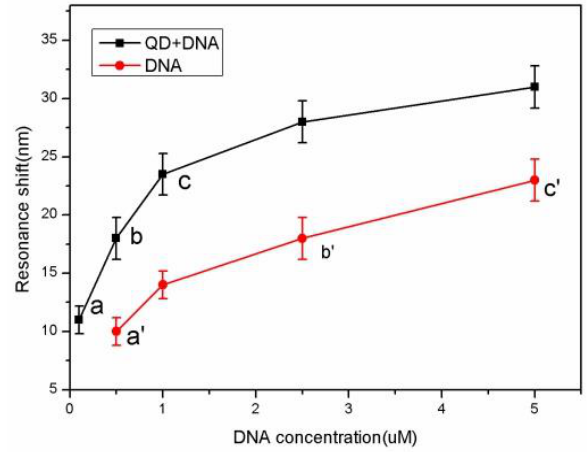
Figure 5. Relationship between the target DNA at different concentrations and the reflectance spectrum shift. The black squares represent the QD-DNA and the red dots represent the control DNA (unlabeled).